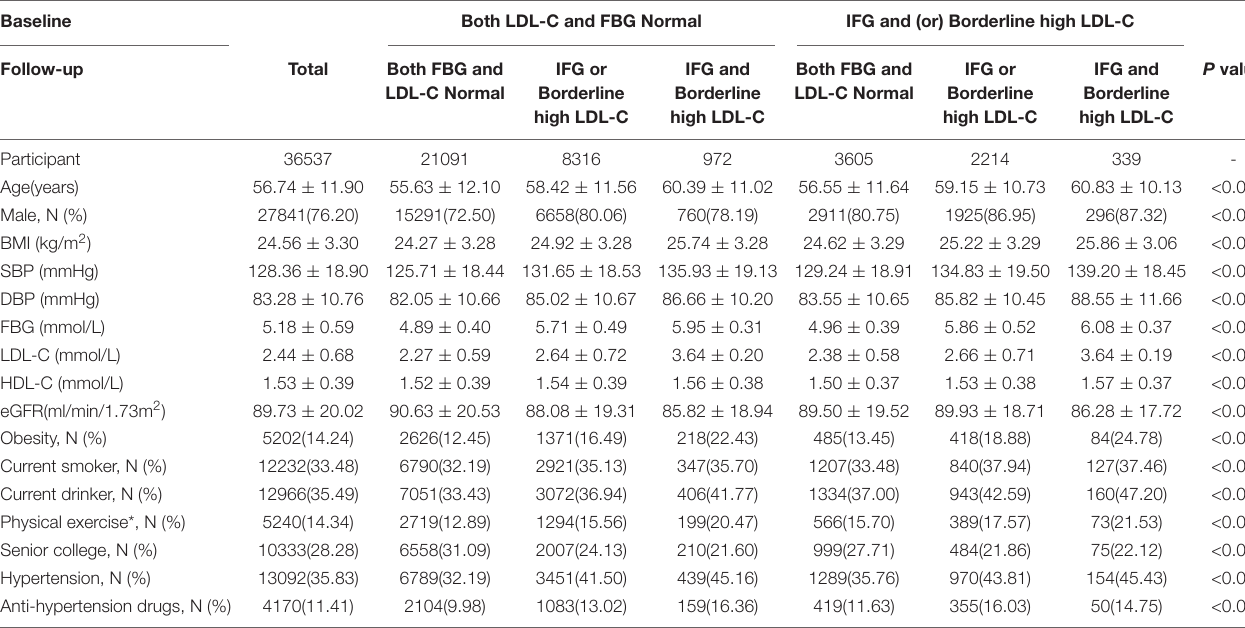
TABLE 1 | Follow-up characteristics of study participants.